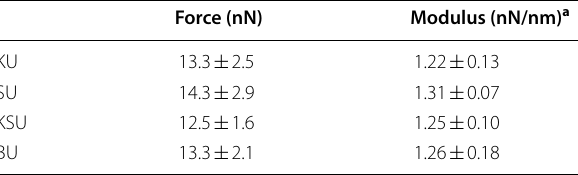
Table 2 Surface stiffness and modulus measured using the AFM force curve mode in the samples coated with